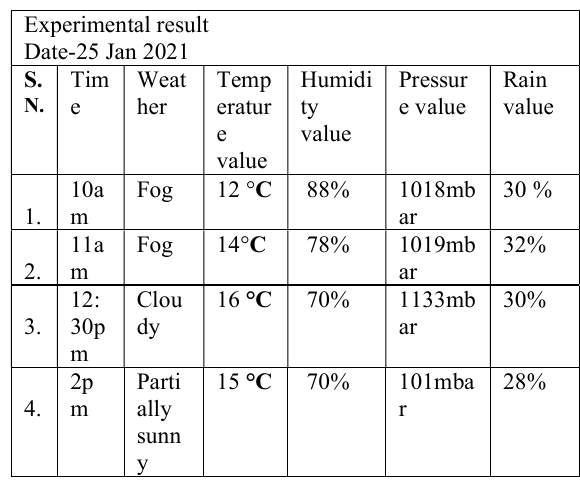
Table 8: Experimental reading obtained at Gida